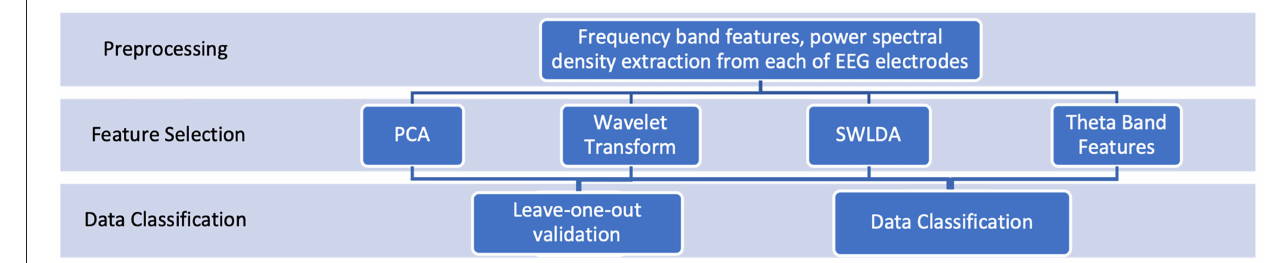
FIGURE 2 | Analysis framework: Our analysis is based on frequency band features extracted from EEG1 and EEG2. To justify our numerical analysis framework, we examined and compared the performances of different feature selection and classification techniques. We reported all numerical results.